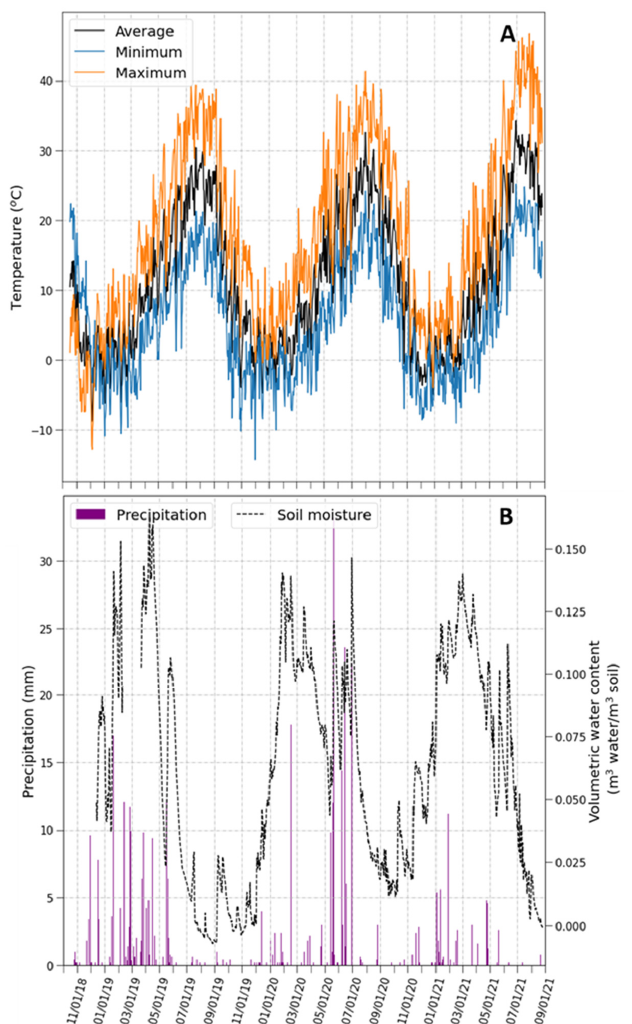
Figure 1. Weather conditions during the experimental period. ( A ) Temperature. ( B ) Soil moisture in the upper 20 cm of the soil and precipitation.